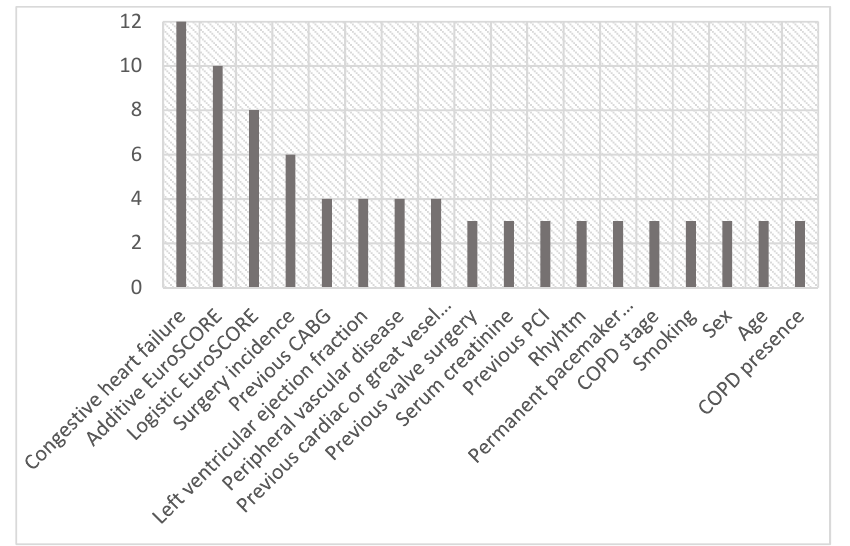
Figure 2. Selected features and their ranks in % as calculated across the MC folds. Ranks represent the relative importance of selected features for model building.